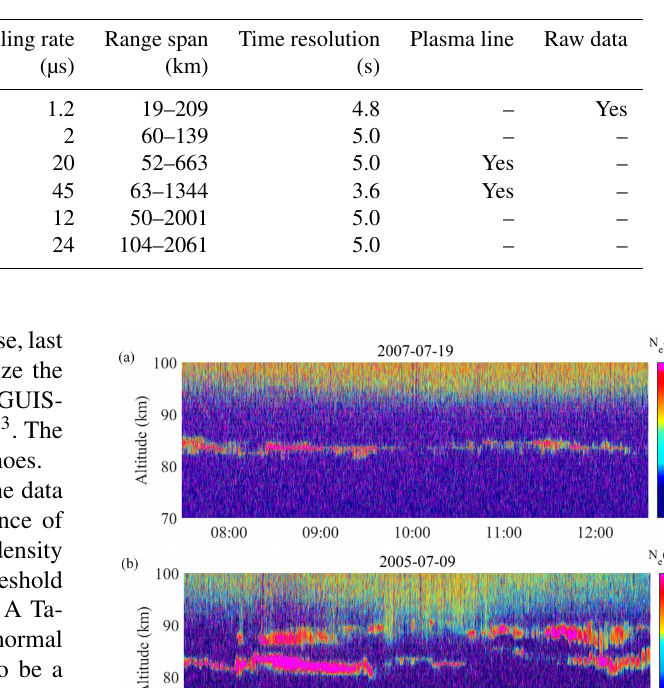
Table 2. EISCAT VHF radar standard experiments.